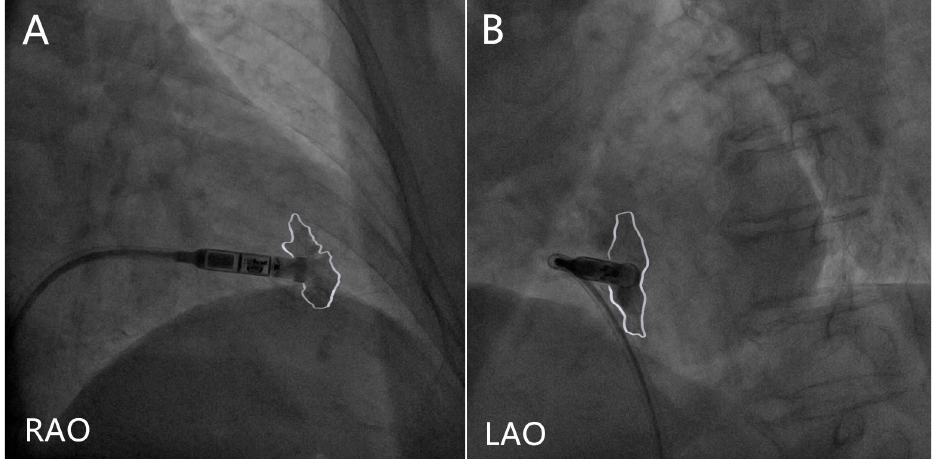
Figure 1. Contrast injection in right anterior oblique (RAO) and left anterior oblique (LAO) projections. The white lines delineate the contrast outlines. ( A ) The contrast seen both in front of and inferior to the tip of the delivery catheter in RAO projection suggests a non-apical location. ( B ) The contrast delineates the ventricular septum in LAO projection.